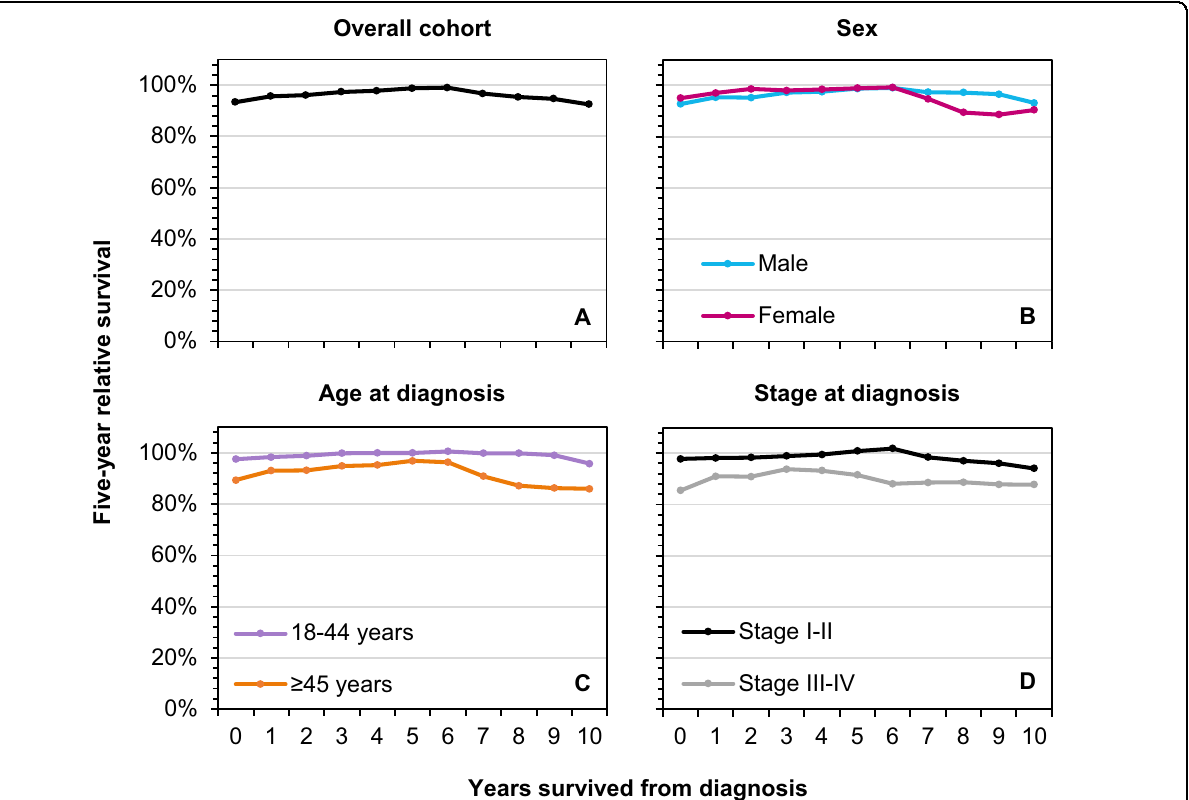
Fig. 1 Conditional 5-year relative survival up to 10 years post-diagnosis among adult patients with nodular lymphocyte-predominant Hodgkin lymphoma. Conditional 5-year relative survival up to 10 years post-diagnosis among adult patients with nodular lymphocyte-predominant Hodgkin lymphoma in the Netherlands according to ( A ) the overall cohort and by ( B ) sex, ( C ) age at diagnosis, and ( D ) stage at